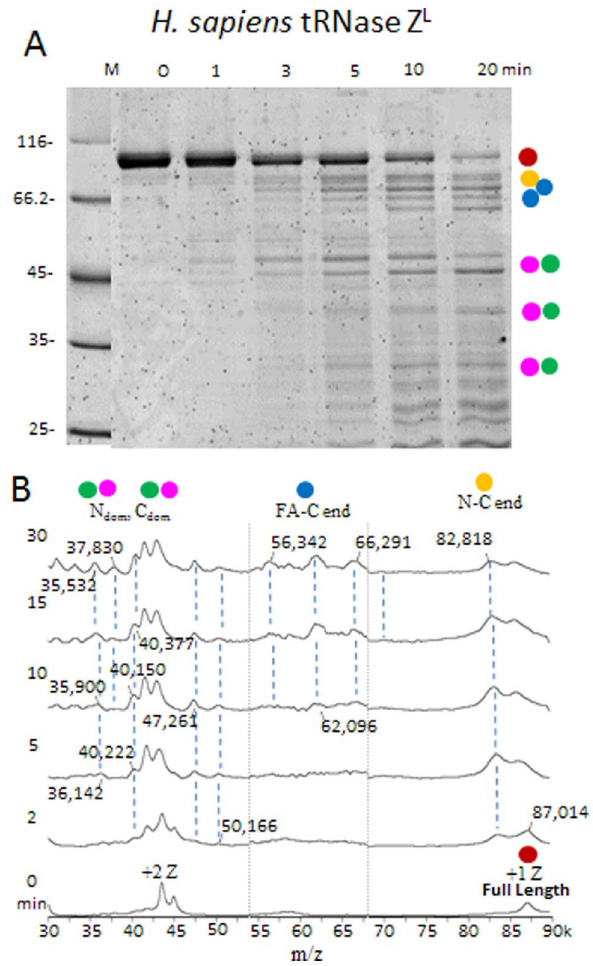
Figure 8. H. sapiens tRNase Z L displays flexible regions like those in D. melanogaster tRNase Z . H. sapiens tRNase Z L was expressed from G 50 as previously described [17]. A) SDS-PAGE is the same as in Figure 3A. B) Presentation of the spectra and labeling of peaks is as in Figure 3B. The complete table is presented in Supplementary Table